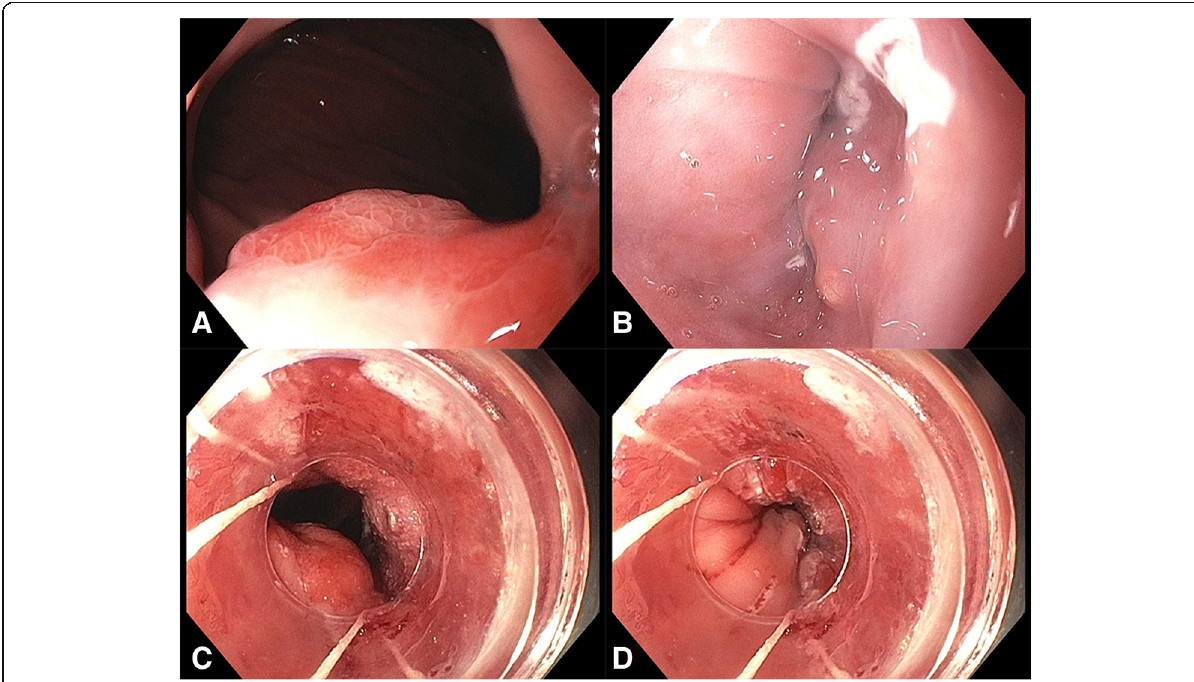
Fig. 1 Endoscopy. a Mass view from stomach. b Mass view from esophagus. c Post-resection view when esophagus was dilated. d Post-resection view when esophagus was